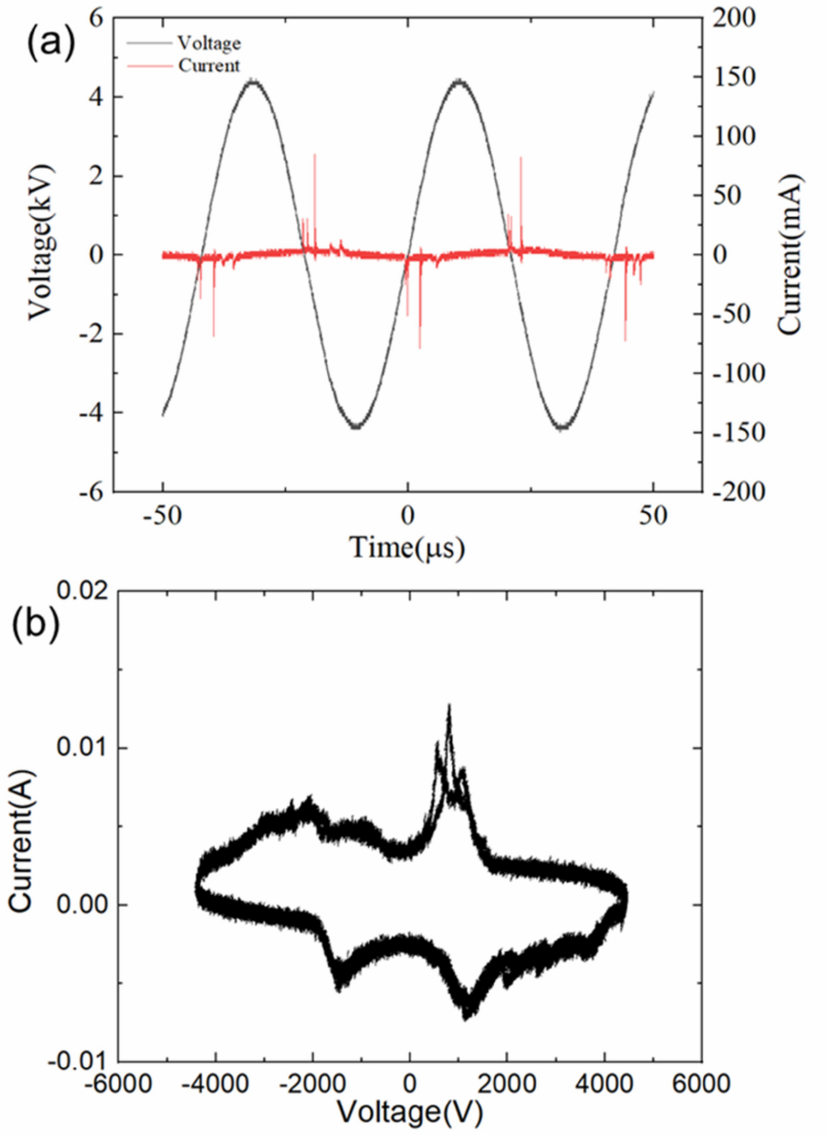
Figure 3. ( a ) Current and voltage characteristics of the LPT jet array (with the working gas of argon alone). Because the difference of the CVC between argon, argon + 0.1% O 2 , argon + 1% O 2 was negligible, only one group of CVC is plotted. ( b ) The Lissajous figure corresponding to ( a ) was used to calculate the power of the LPT jet